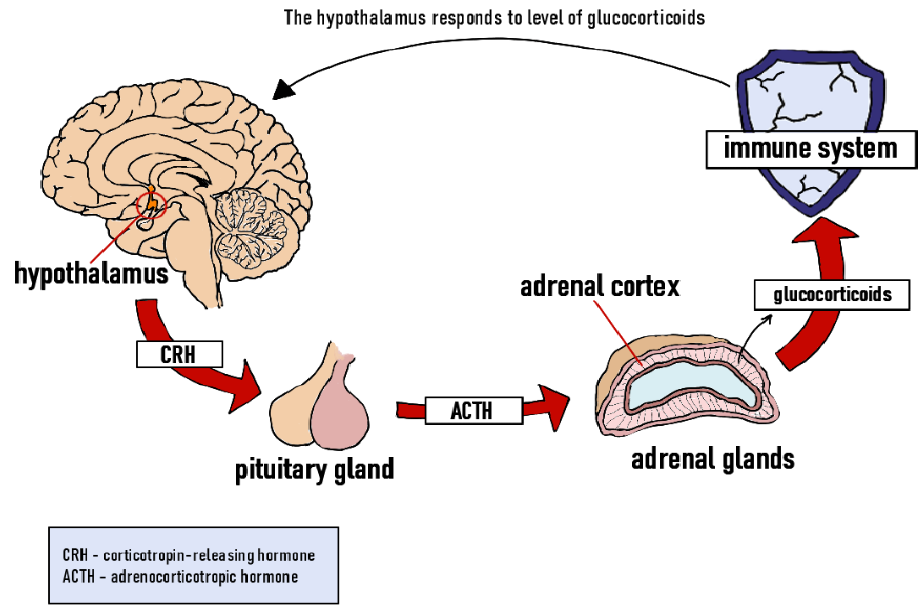
Figure 2. Stress response—the hypothalamic–pituitary–adrenal axis (HPA). Own elaboration based on [36,40–42].